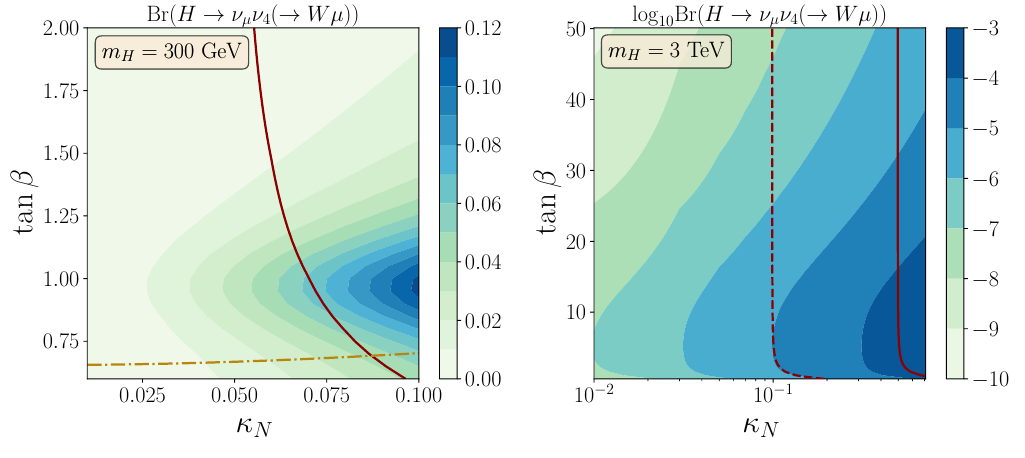
Figure 17 . Branching fractions of the leptonic cascade decay via the lightest neutral vectorlike lepton: H → ν µ ν 4 → V ‘ 2 ν µ for almost SM singlet-like ν 4 . We set m H = 300 (3000) GeV in the left (right) panel. The value of G F is more than 2 σ away from the measured value to the right of the red lines for m N = 250 (2500) GeV in the left (right) panel. In the left panel, the region above the yellow dash-dot line is excluded by the H → ττ search. The red dashed line in the right panel shows the G F constraint for m N = 500 GeV .